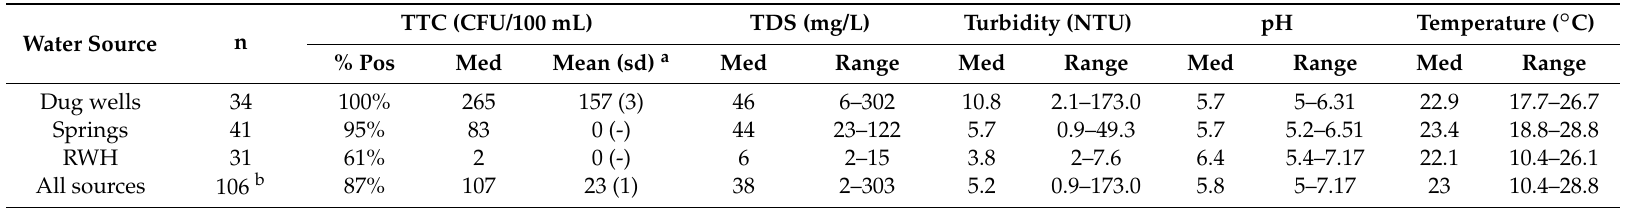
Table 2. Water quality in samples from each source type (dug wells, springs, and rainwater harvesting systems (RWH)), including sample size (n), the percent of water samples positive (% pos) for thermotolerant coliform (TTC) and their median (med) concentration, and the median (med), minimum and maximum (range) of total dissolved solids (TDS), turbidity, pH, and temperature.